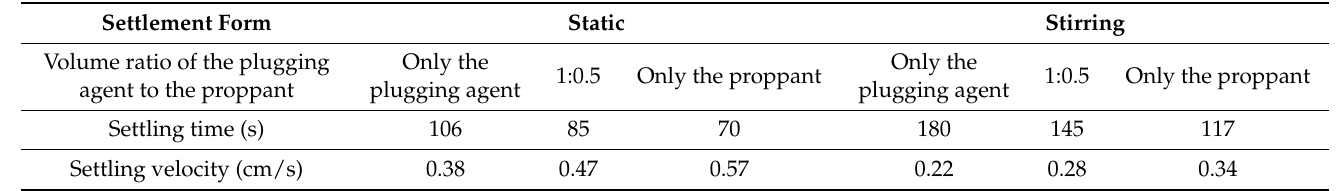
Table 8. Sedimentation rates of the plugging agent and proppant (density = 2.00 g/cm 3 ) in